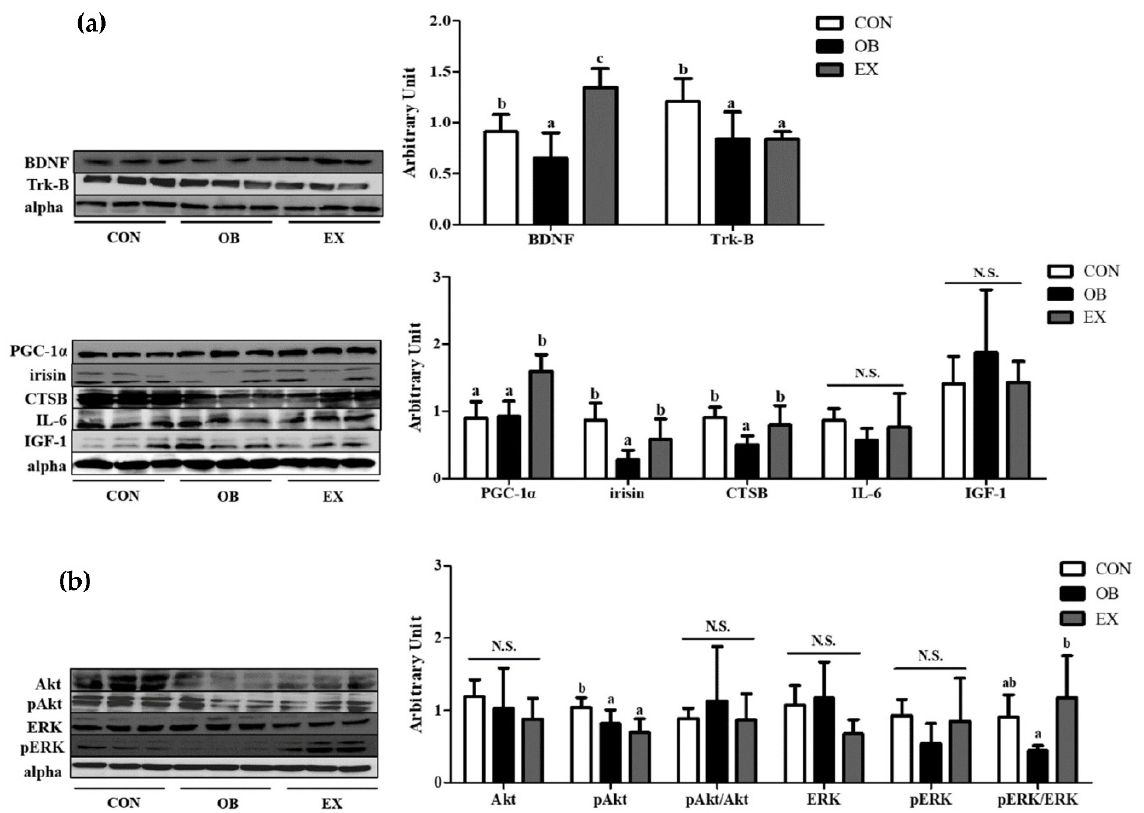
Figure 5. Effects of resistant exercise on skeletal muscle. ( a ) cognitive function-related myokines and ( b ) energy metabolism in sarcopenic obese mice. Values are means ± SD ( n = 5~6). Mean values with the same superscript letter (a, b and c) are not significantly different ( p < 0.05). BDNF: brain-derived neurotrophic factor, Trk-B: tropomyosin receptor kinase B, PGC-1 α : peroxisome proliferator-activated receptor-gamma coactivator 1-alpha, CTSB: cathepsin B, IL-6: interleukin-6, IGF-1: insulin-like growth factor 1, Akt: protein kinase B, ERK1/2: extracellular signal-regulated kinases 1/2. N.S.: no significance.